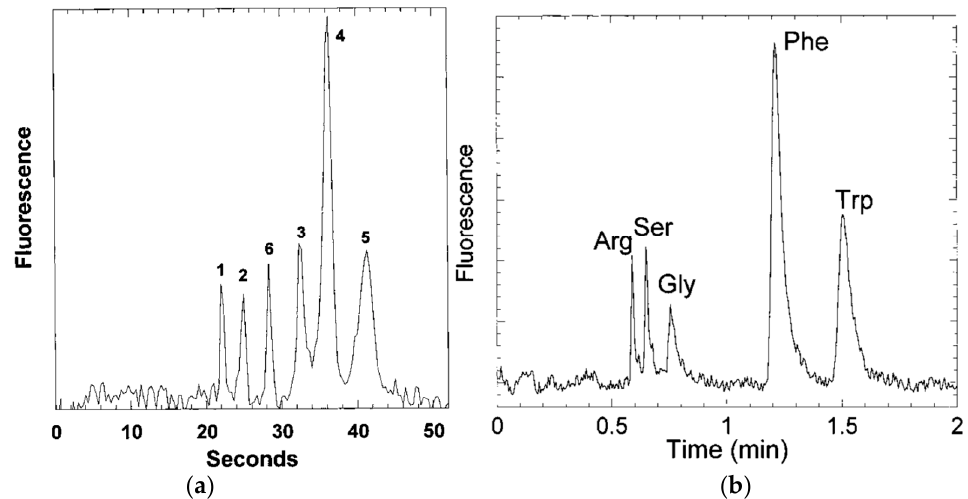
Figure 15. ( a ) Separation of peptide mixture on acrylate monolith. Peptides are (1) papain inhibitor; (2) proctolin; (3) Opioid peptide (R-casein fragment 90–95); (4) Ileangiotensin III; (5) angiotensin III; and (6) GGG; ( b ) Separation of amino acid mixture on same monolith. Image adapted with permission from [159]. Copyright (2002), American Chemical Society.